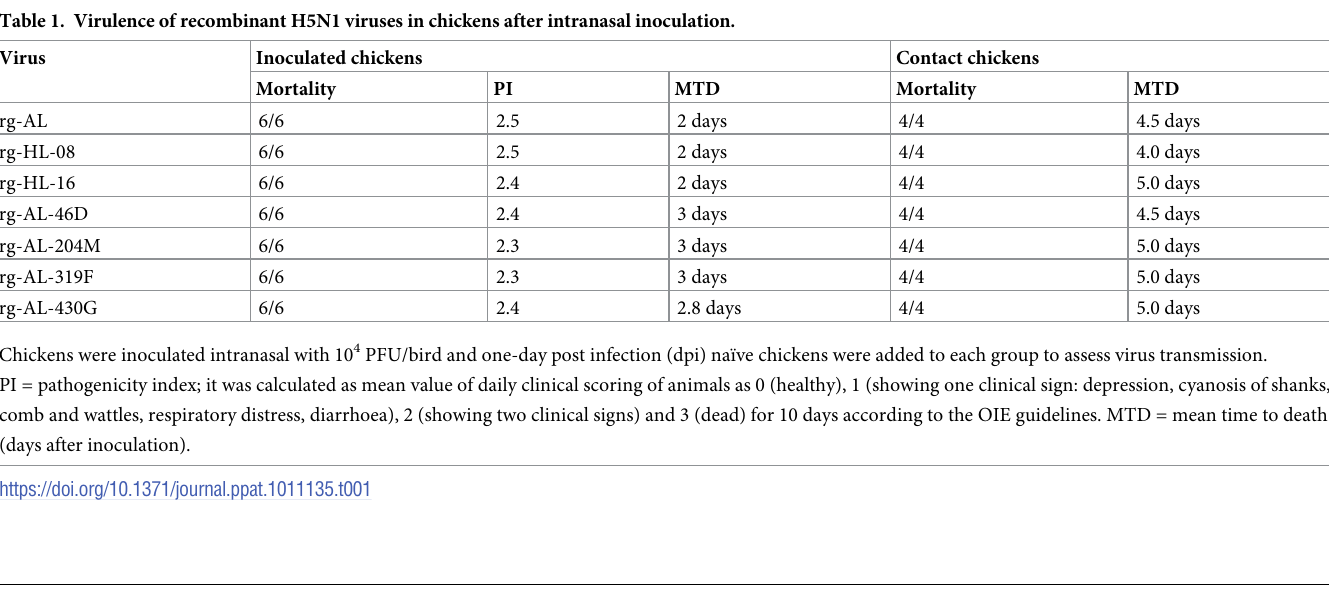
Table 1. Virulence of recombinant H5N1 viruses in chickens after intranasal inoculation. Virus Inoculated chickens Contact chickens